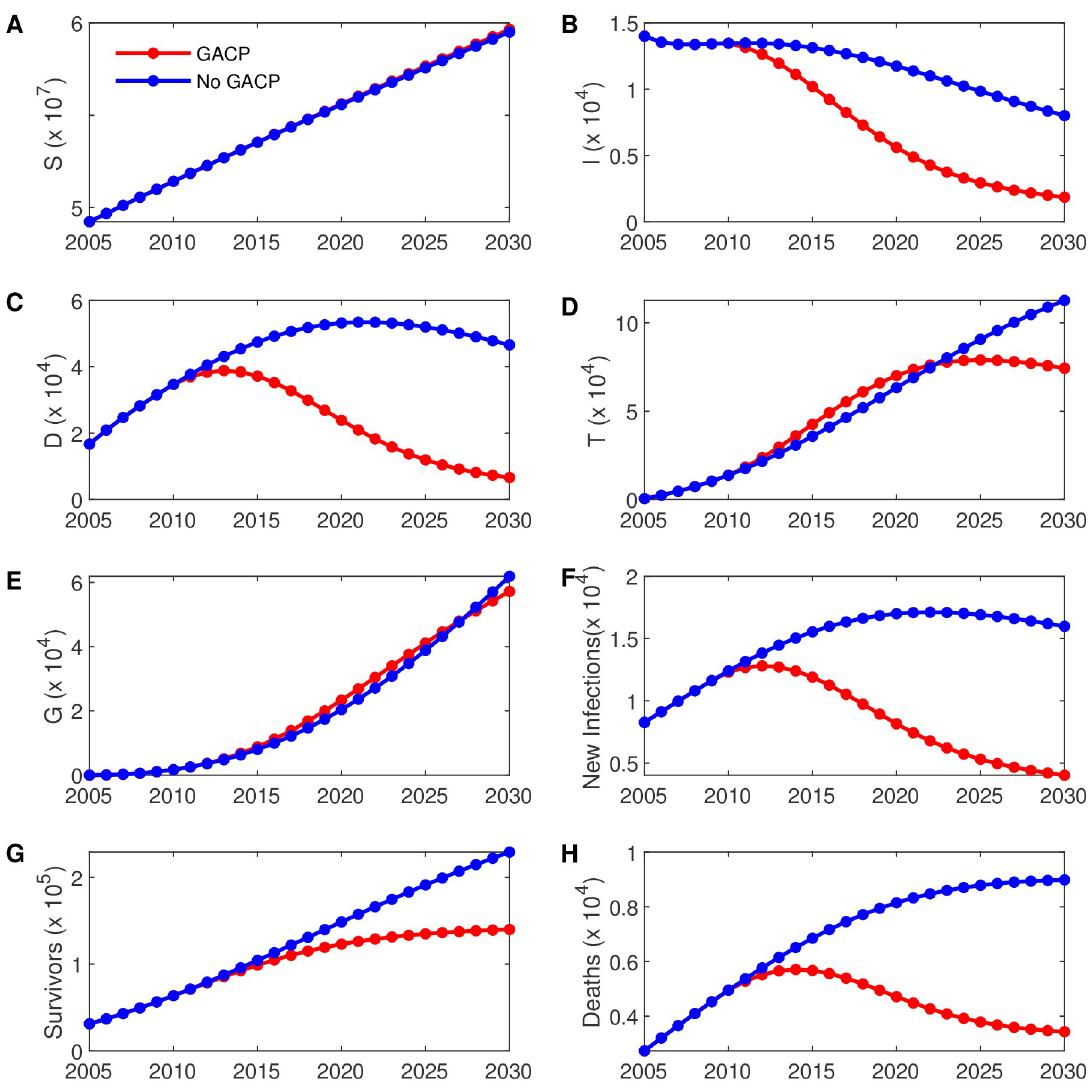
Fig 5. Comparison of the effects of implementing GACP and not implementing GACP. (A)—(H) The growth of (S, I, D, T, G, new HIV/AIDS infections, AIDS survivors, AIDS deaths) without the GACP project (in blue) and with GACP project (in red) from 2005 to